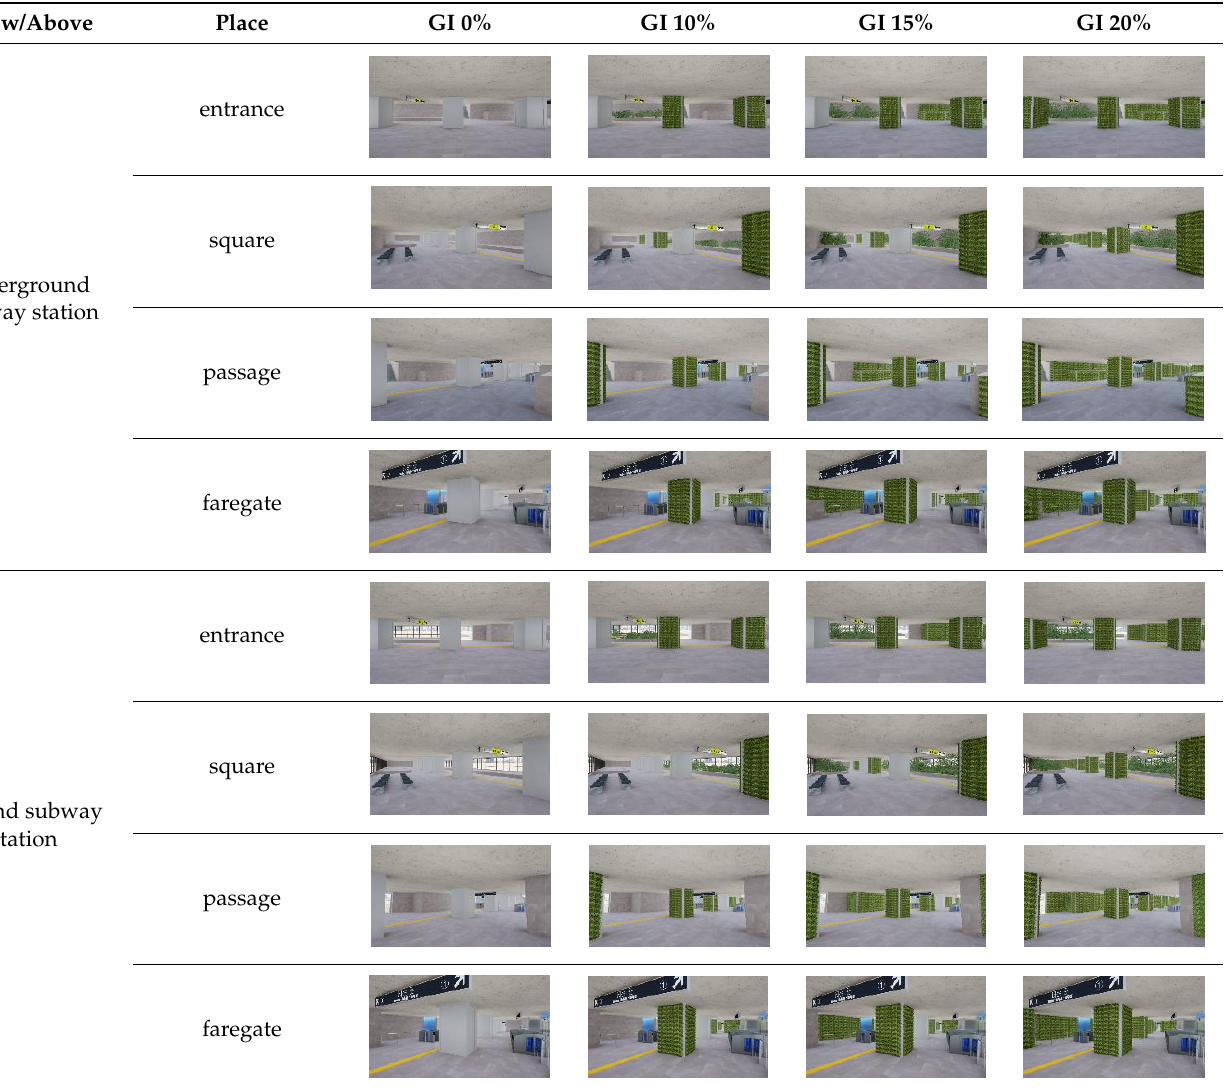
Table 1. Image of Subway Interior Landscape Model according to GI.